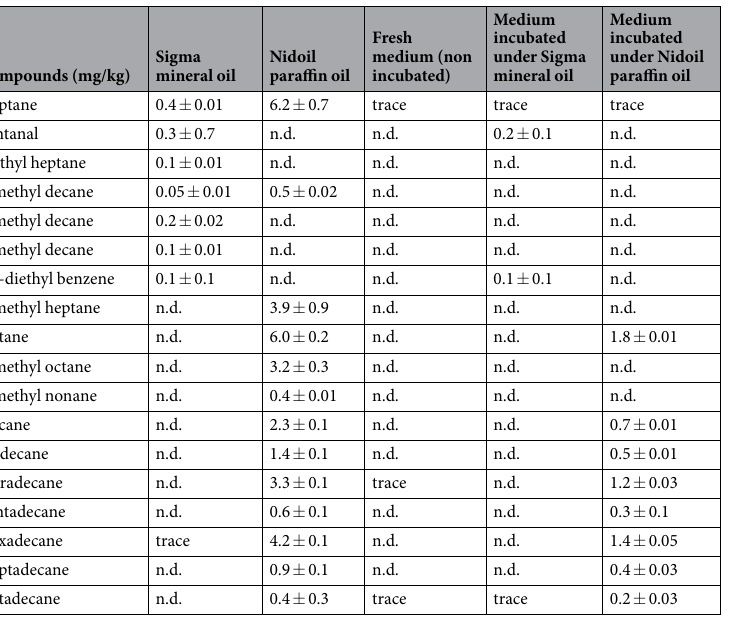
Table 3. Volatile compounds determined in 5 days incubated mineral oil, paraffin oil, and embryo culture medium covered with mineral and paraffin oils. n.d., not detected. The values are expressed as mean ± SD (four